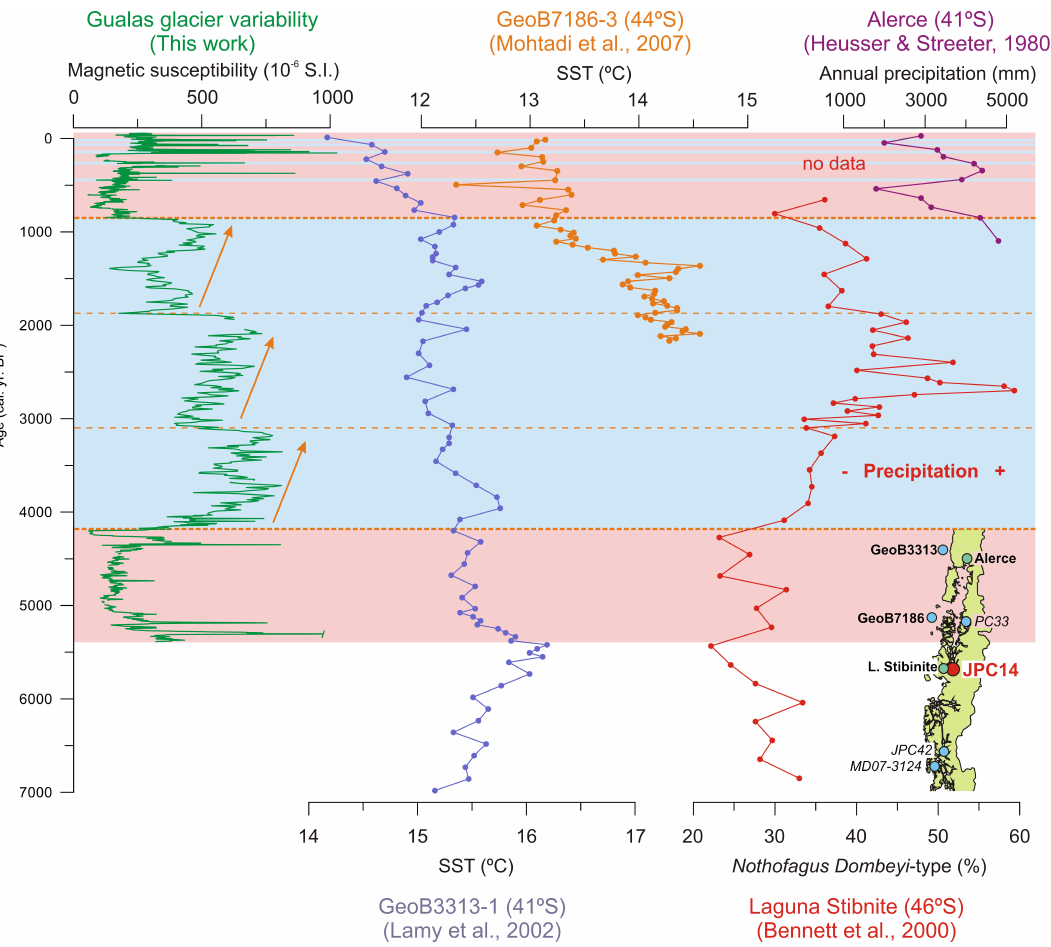
Fig. 10. Comparison of the magnetic susceptibility record of sediment core JPC14 with regional SST and precipitation records. The upper part of the pollen-derived precipitation record of Heusser and Streeter (1980) is represented to complement the Laguna Stibnite record during the last millennium. The rest of the Alerce pollen record of Heusser and Streeter (1980) is not represented because of (1) a weak chronology, (2) the relatively low resolution of the record, and (3) the unavailability of the raw data. Inset: location of the records used in this figure and discussed in the text, on a simplified map of Chile from 40 to 51.5 ◦ S. Names in bold and in italics represent records shown in this figure or discussed in the text,